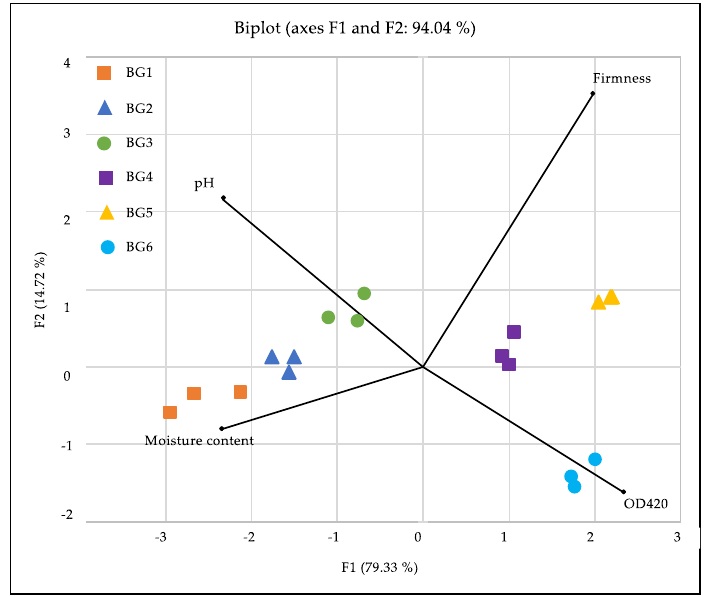
Figure 2. Principal component analyses of physicochemical properties; BG1, BG2, BG3, BG4, BG5 and BG6 were processed from FG with different iMC namely 72.60%, 66.78%, 59.99%, 56.44% 51.15% and 49.95%, respectively.